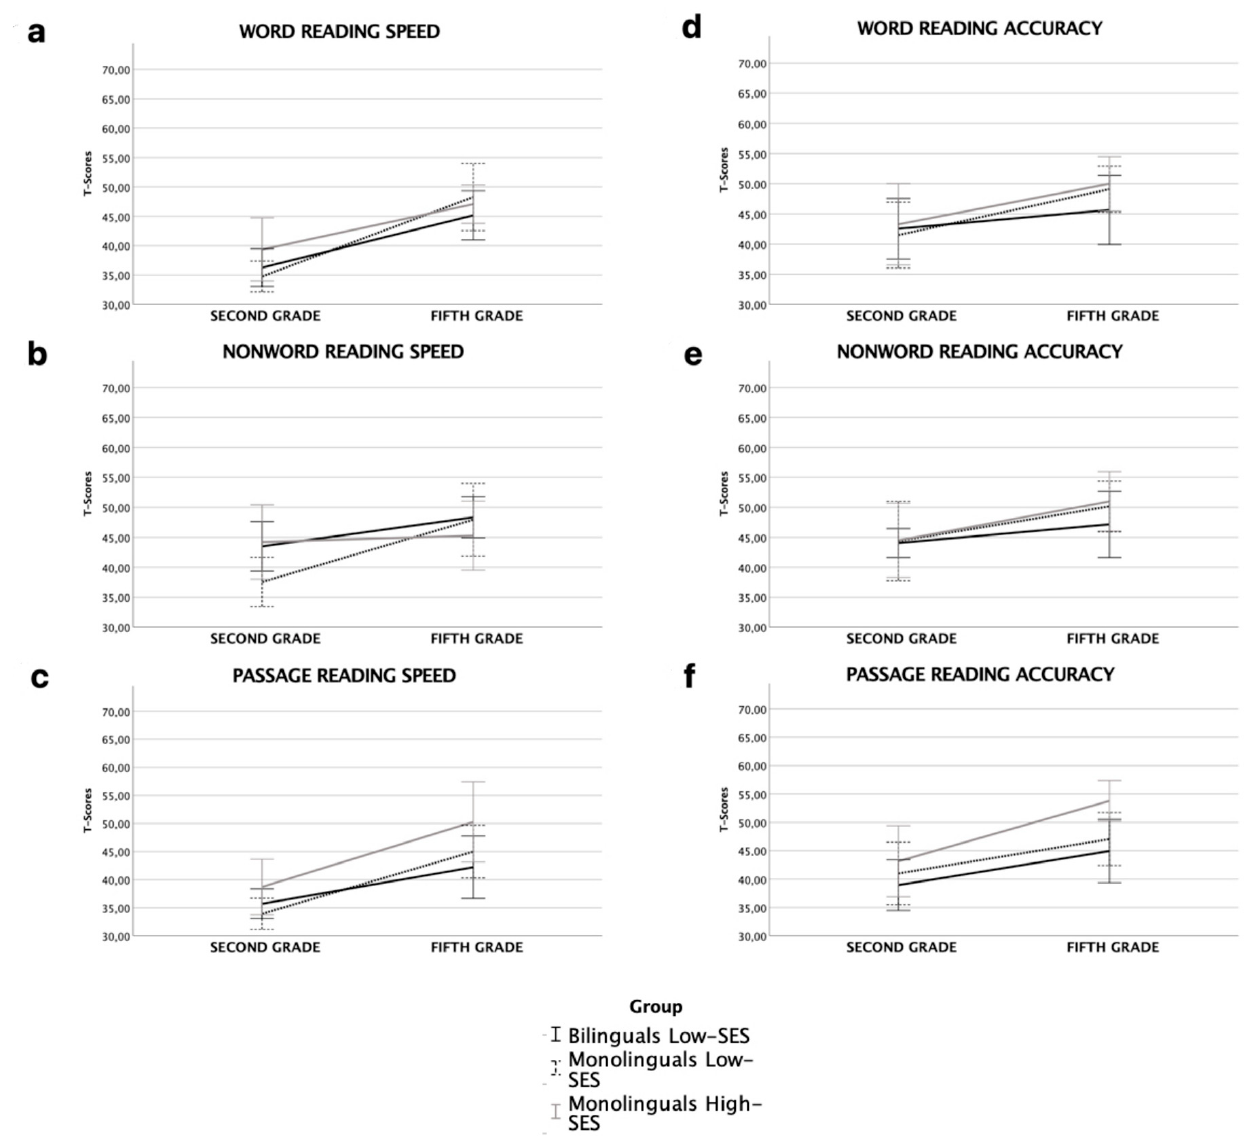
Figure 1. Line bars representing decoding skills (T-scores) in word reading speed ( a ), nonword reading speed ( b ), passage reading speed ( c ), word reading accuracy ( d ), nonword reading accuracy ( e ) and passage reading accuracy ( f ) in second and fifth grade for the three groups (error bars: 95%